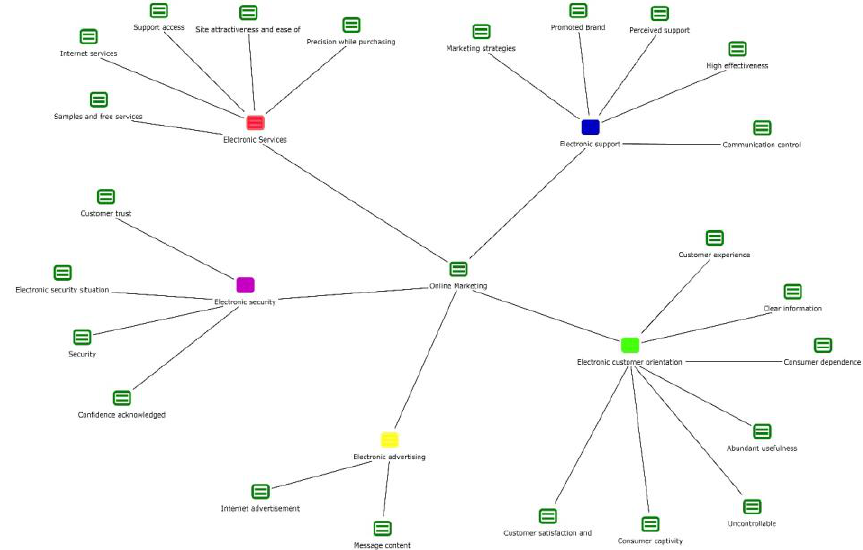
Figure 1: Network of components of online marketing